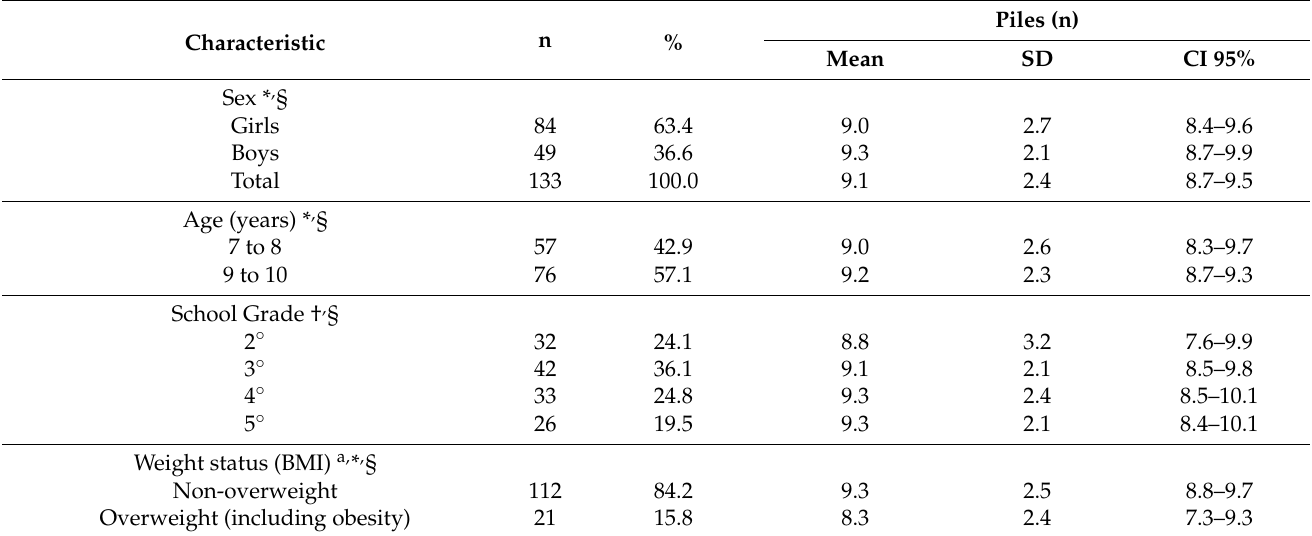
Table 2. Sociodemographic characteristics according to number of piles of 7–10-year-old schoolchil- dren, Florian ó polis, Southern Brazil,